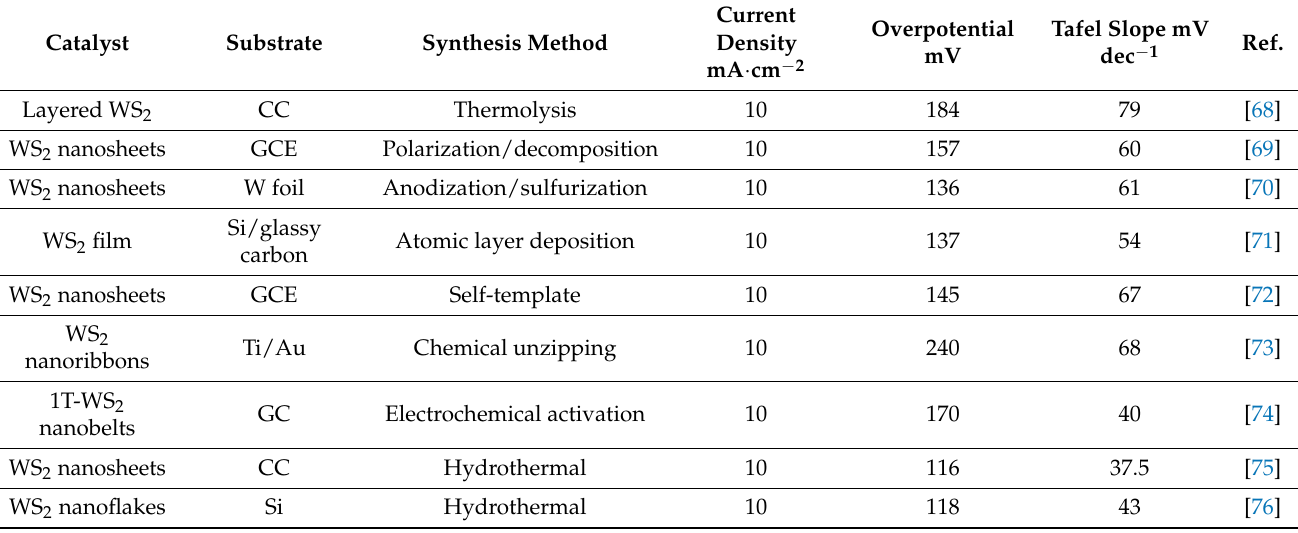
Table 1. The HER performance of WS 2 with different